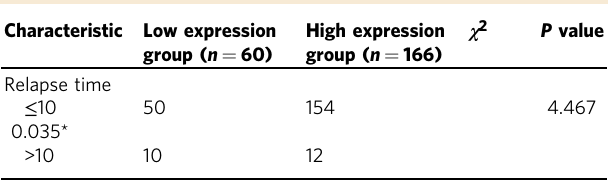
Table 2 Relationship between CHML expression and patients ’ relapse time Characteristic Low expression group ( n = 60)